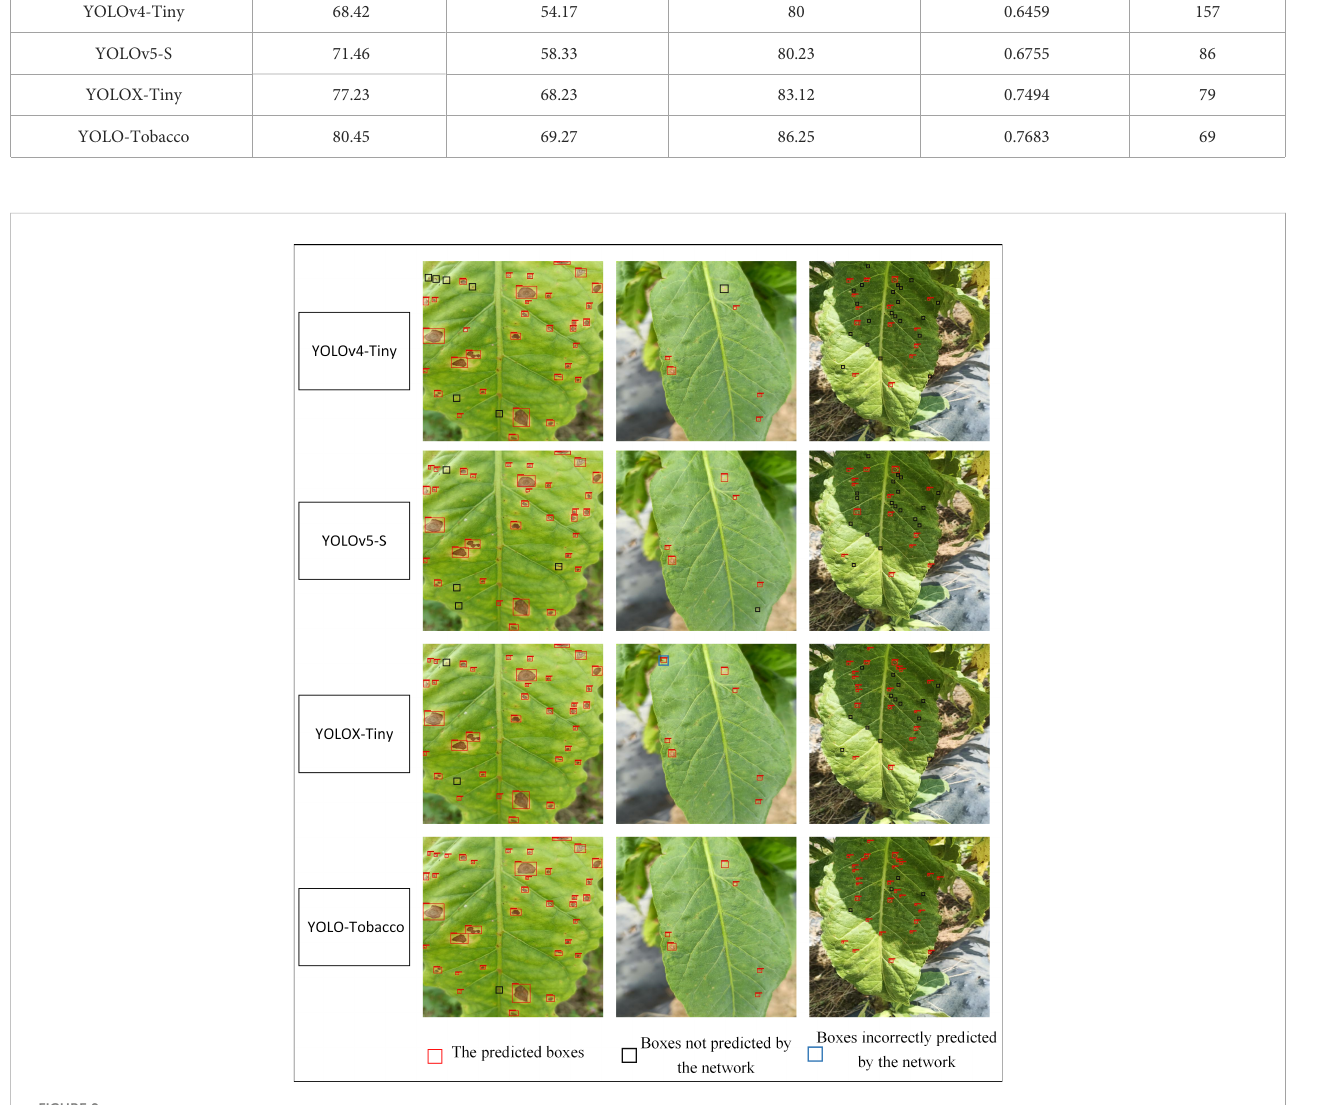
FIGURE 9 The comparison of different methods for the detection of brown spot